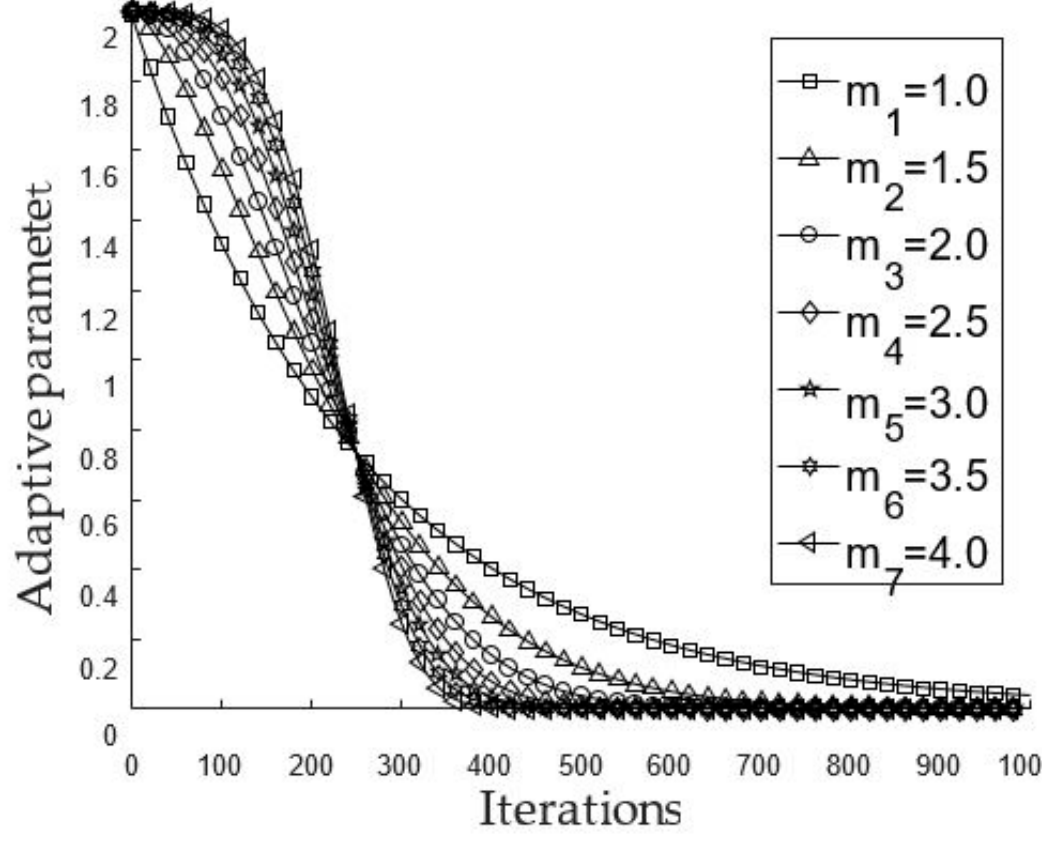
Figure 2. Change curve of c .